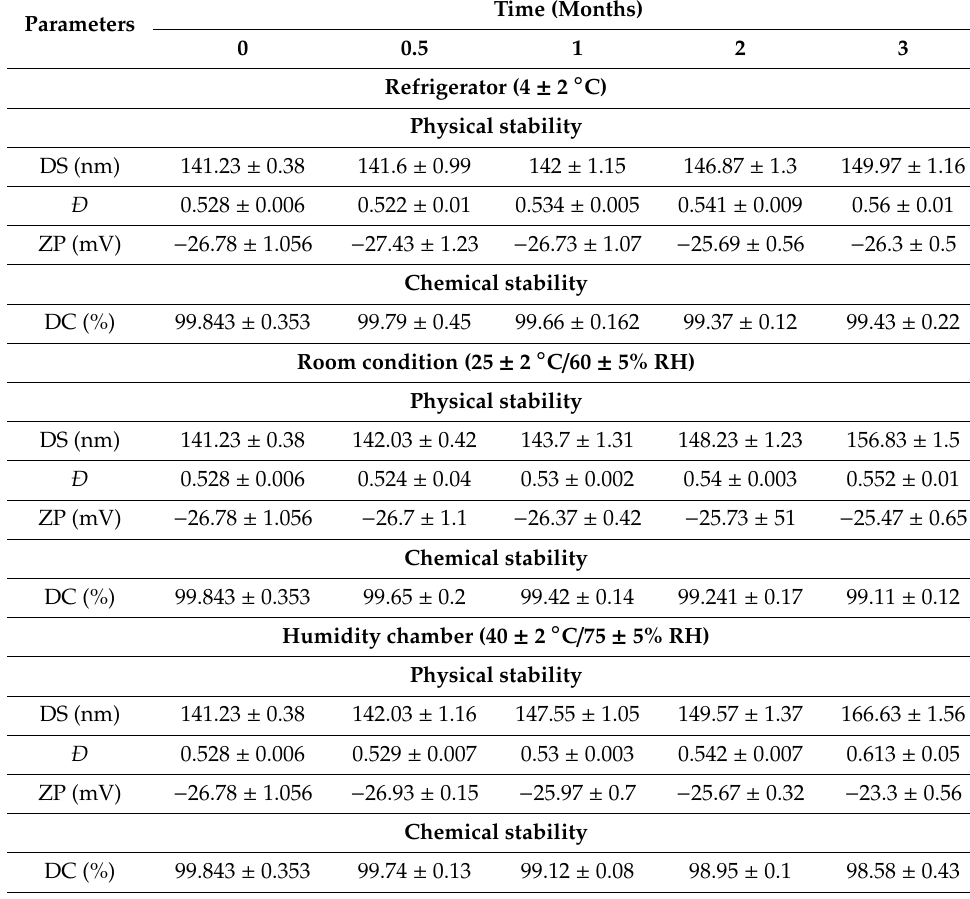
Table 8. Stability studies for AZM-L-F1 (H) formulation under the three di ff erent storage conditions. Mean ± SD, n = 3.